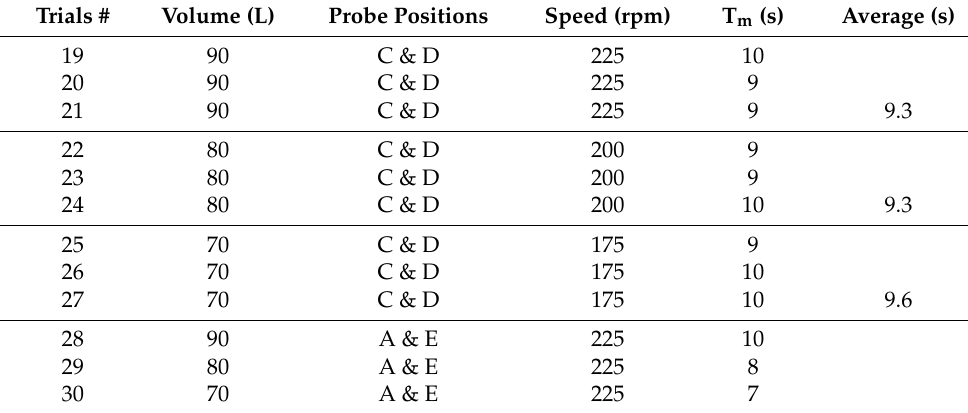
Table 4. Mixing time trials with probe positions C & D and A &